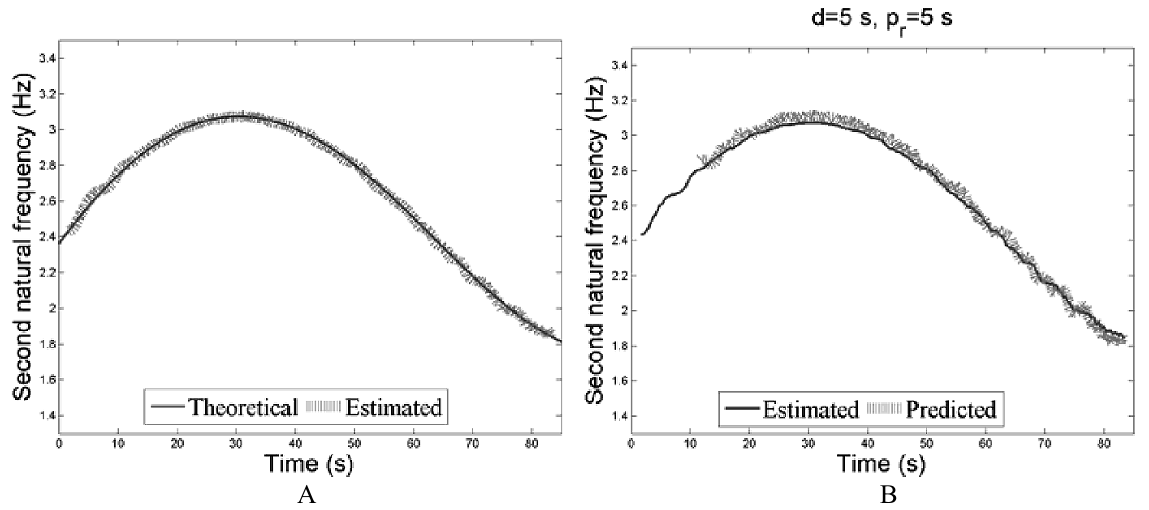
Fig. 2. Second natural frequency. A: Comparison theoretical-estimated. B: Comparison estimated-predicted.